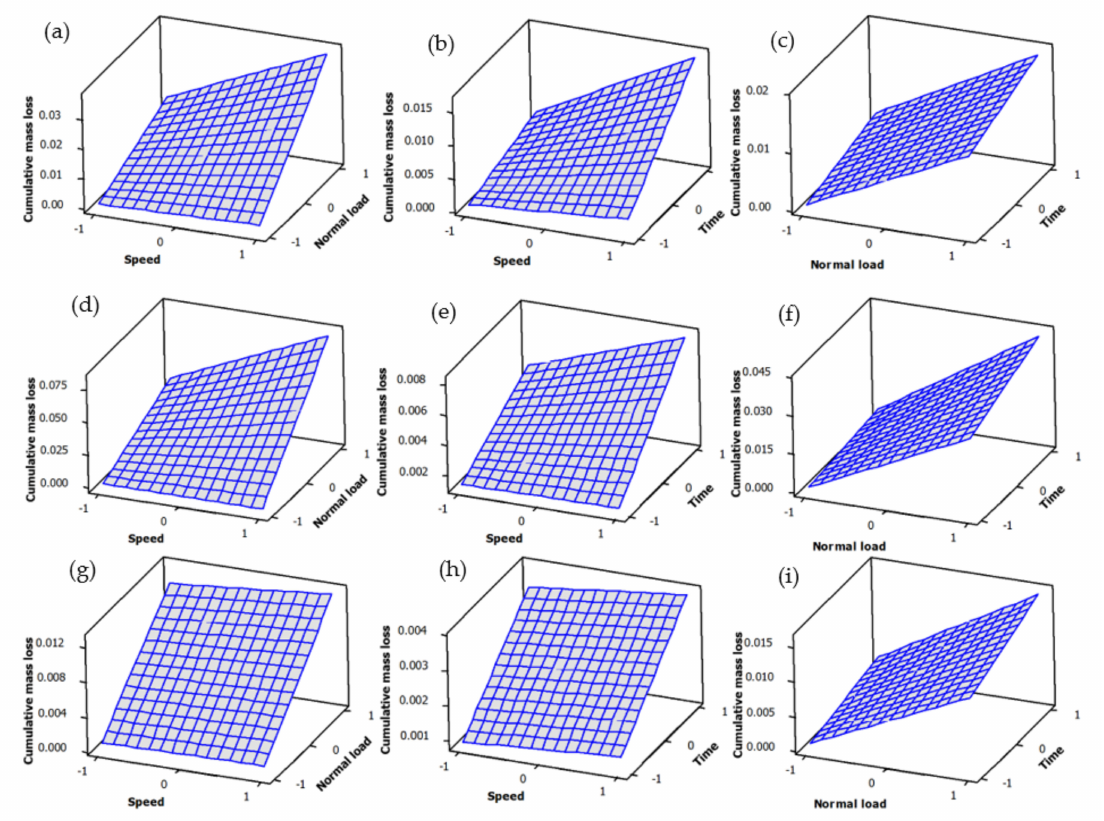
Figure 11. Response surfaces of cumulative mass loss vs. normal load and speed, time and speed, and time and normal load for ( a – c ) Al–1.3%Si, ( d – f ) Al–1.5%Si and ( g – i ) Al–13.5%Si